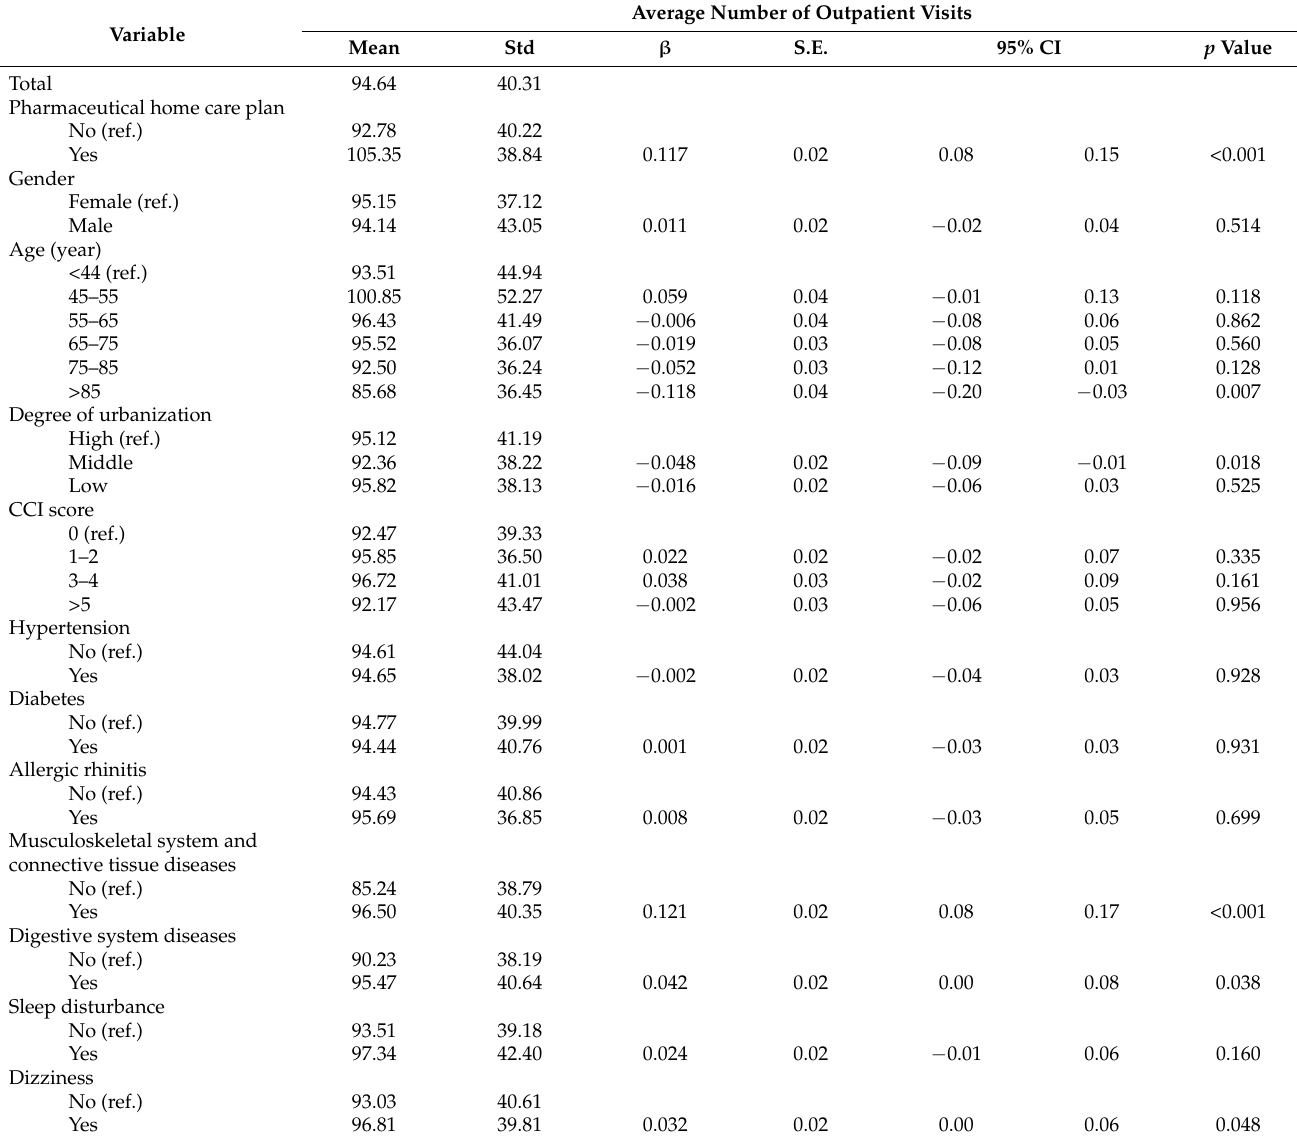
Table 3. The impact of participation in the program on the number of outpatient